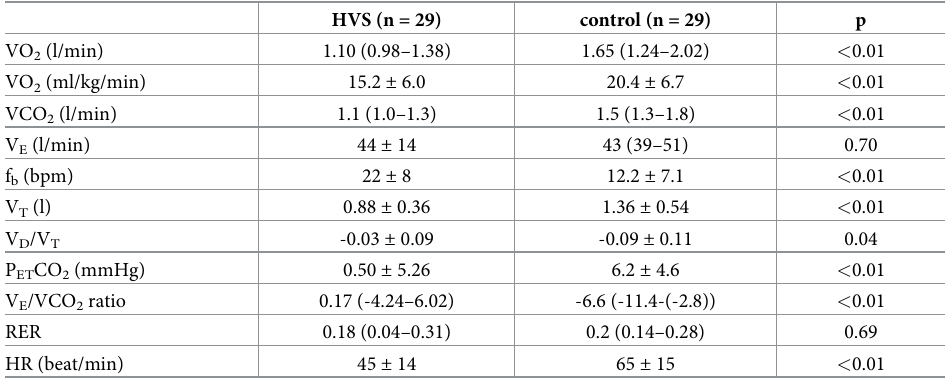
Table 3. Change of ventilatory parameters (peak-rest).